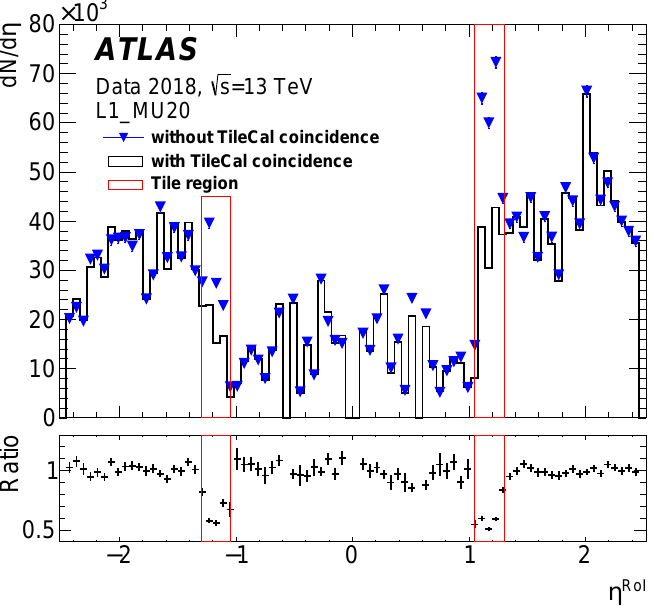
Figure 9. The pseudorapidity distribution, reconstructed using online information, of particles with transverse momentum above 20 GeV in events selected with the first level muon trigger (blue triangles) and the Tile-muon trigger (black line). Their ratio is shown in the lower pad. The coincidence region is highlighted with redrectangles